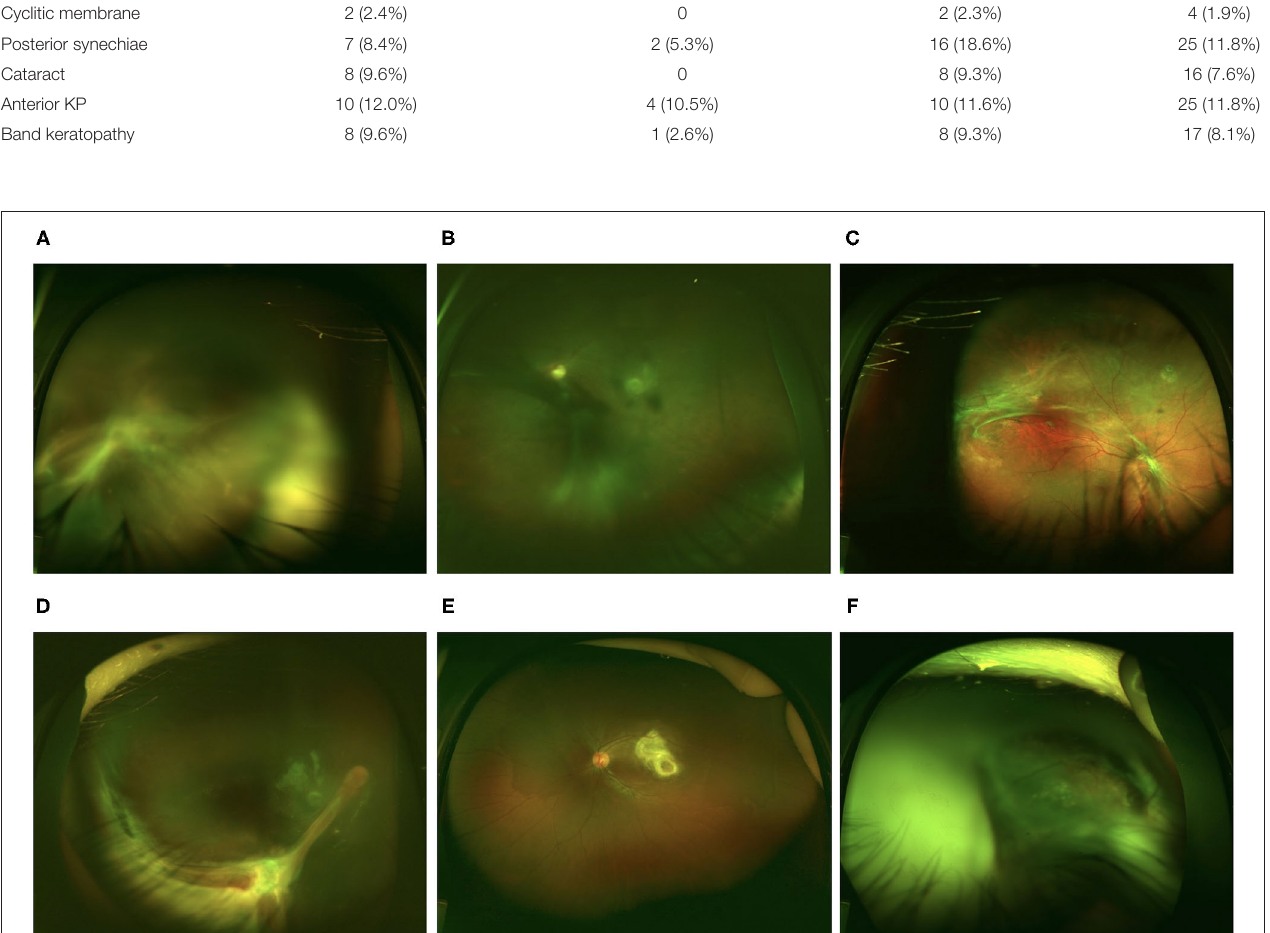
FIGURE 1 | Representative retinal images of eyes with ocular toxocariasis (OT). (A–C) Endophthalmitis type OT. (A) Diffusive vitritis with vitreous strands extending to the retina. (B) Diffusive vitritis with vitreous membrane. (C) Fibrotic membrane at the retina surface with relatively clear vitreous. (D) Peripheral granuloma with retinal fold extending to the optic disc. (E) Posterior pole granuloma. (F) Total retinal detachment with vitritis.